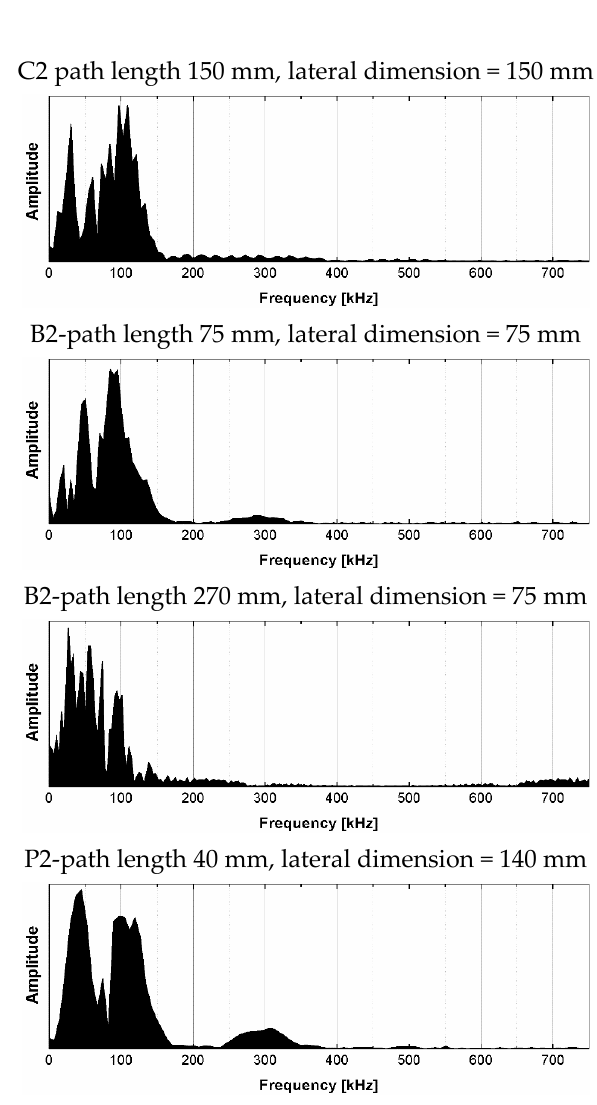
Figure 8. Pulse velocity plotted against minimal lateral dimension.